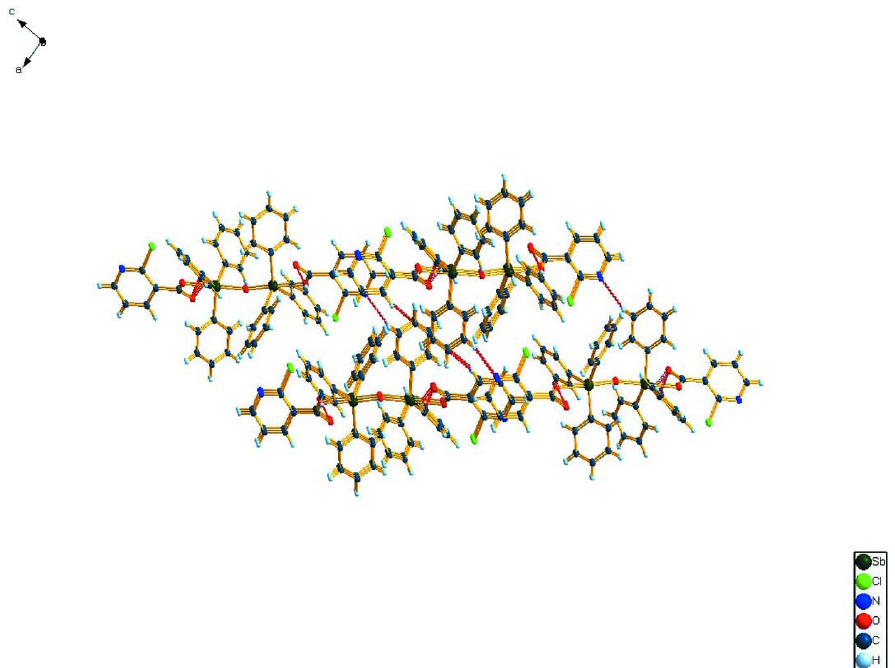
Figure 2 A 3D network of hydrogen bonds in the crystal structure of the title compound. Symmetry code: (i) x , y +1, z ; (ii) - x +1, - y , - z +1; (iii) x , y -1, z ; (iv) x , y -1, z